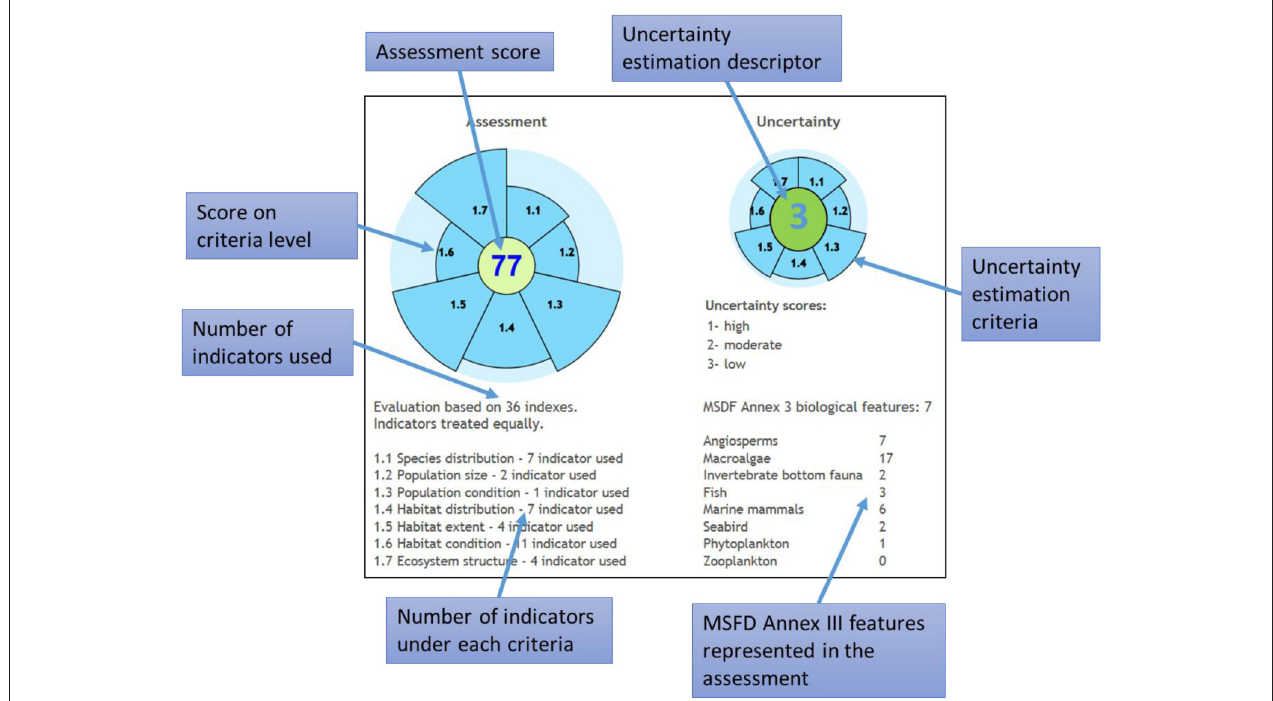
FIGURE 7 | Information displayed at result screen of MARMONI biodiversity assessment tool. MSFD, Marine Strategy Framework Directive.